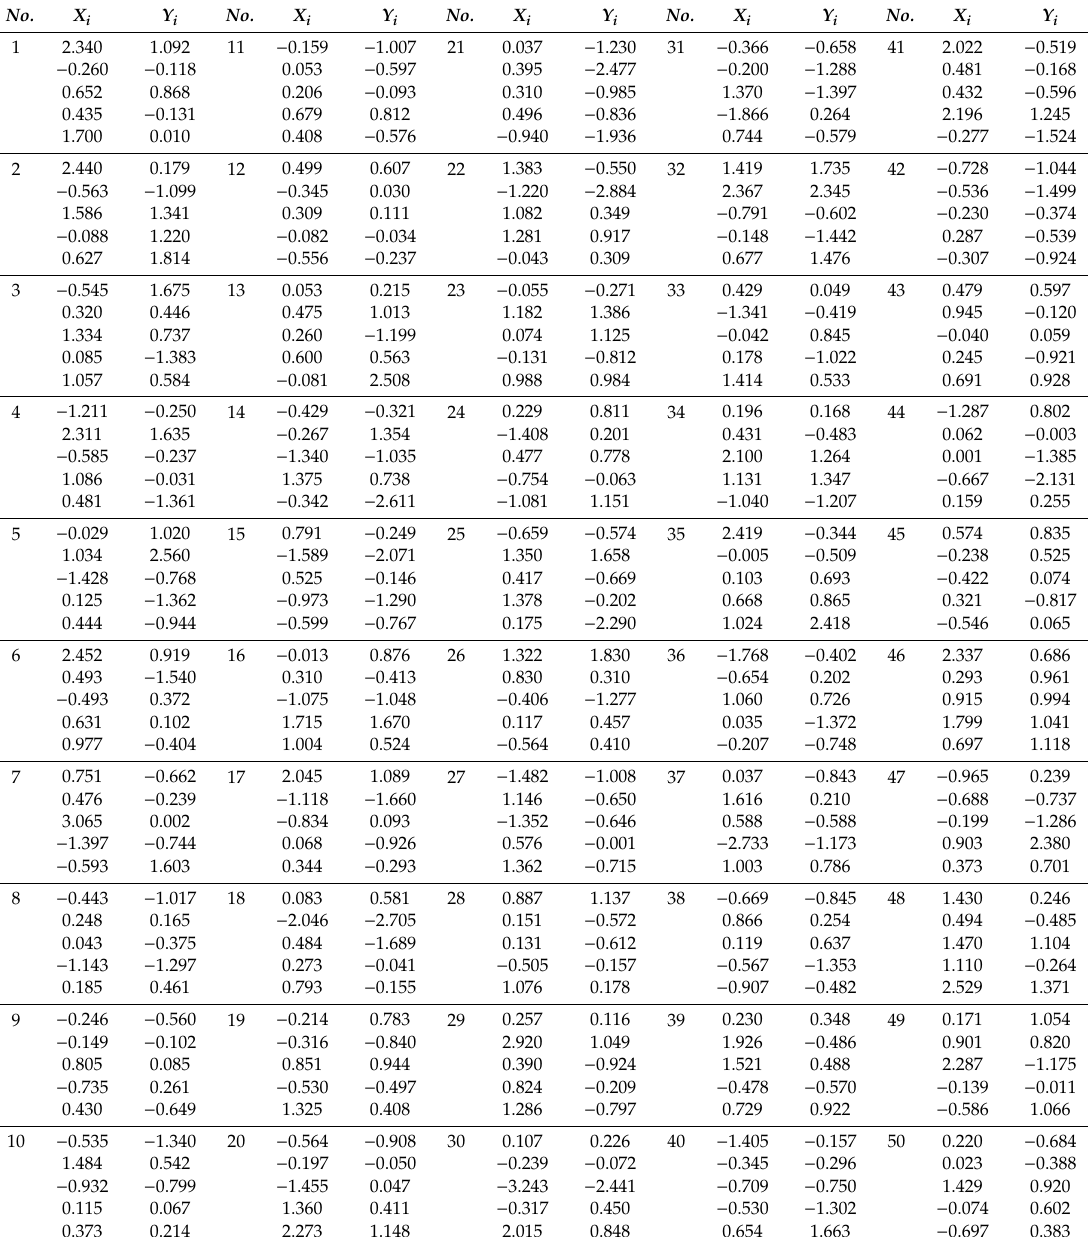
Table 5. Simulation bivariate dataset at process mean shift δ = 0.0 in first 20 samples and δ = 0.2 in the last 30 samples when ρ =